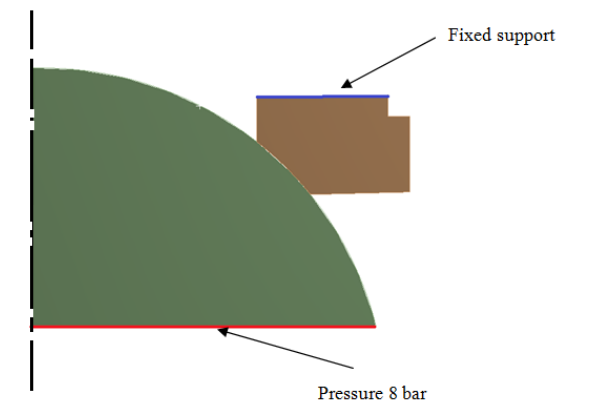
Figure 4: Bilinear isotropic model of the PTFE material used in FEM simulation